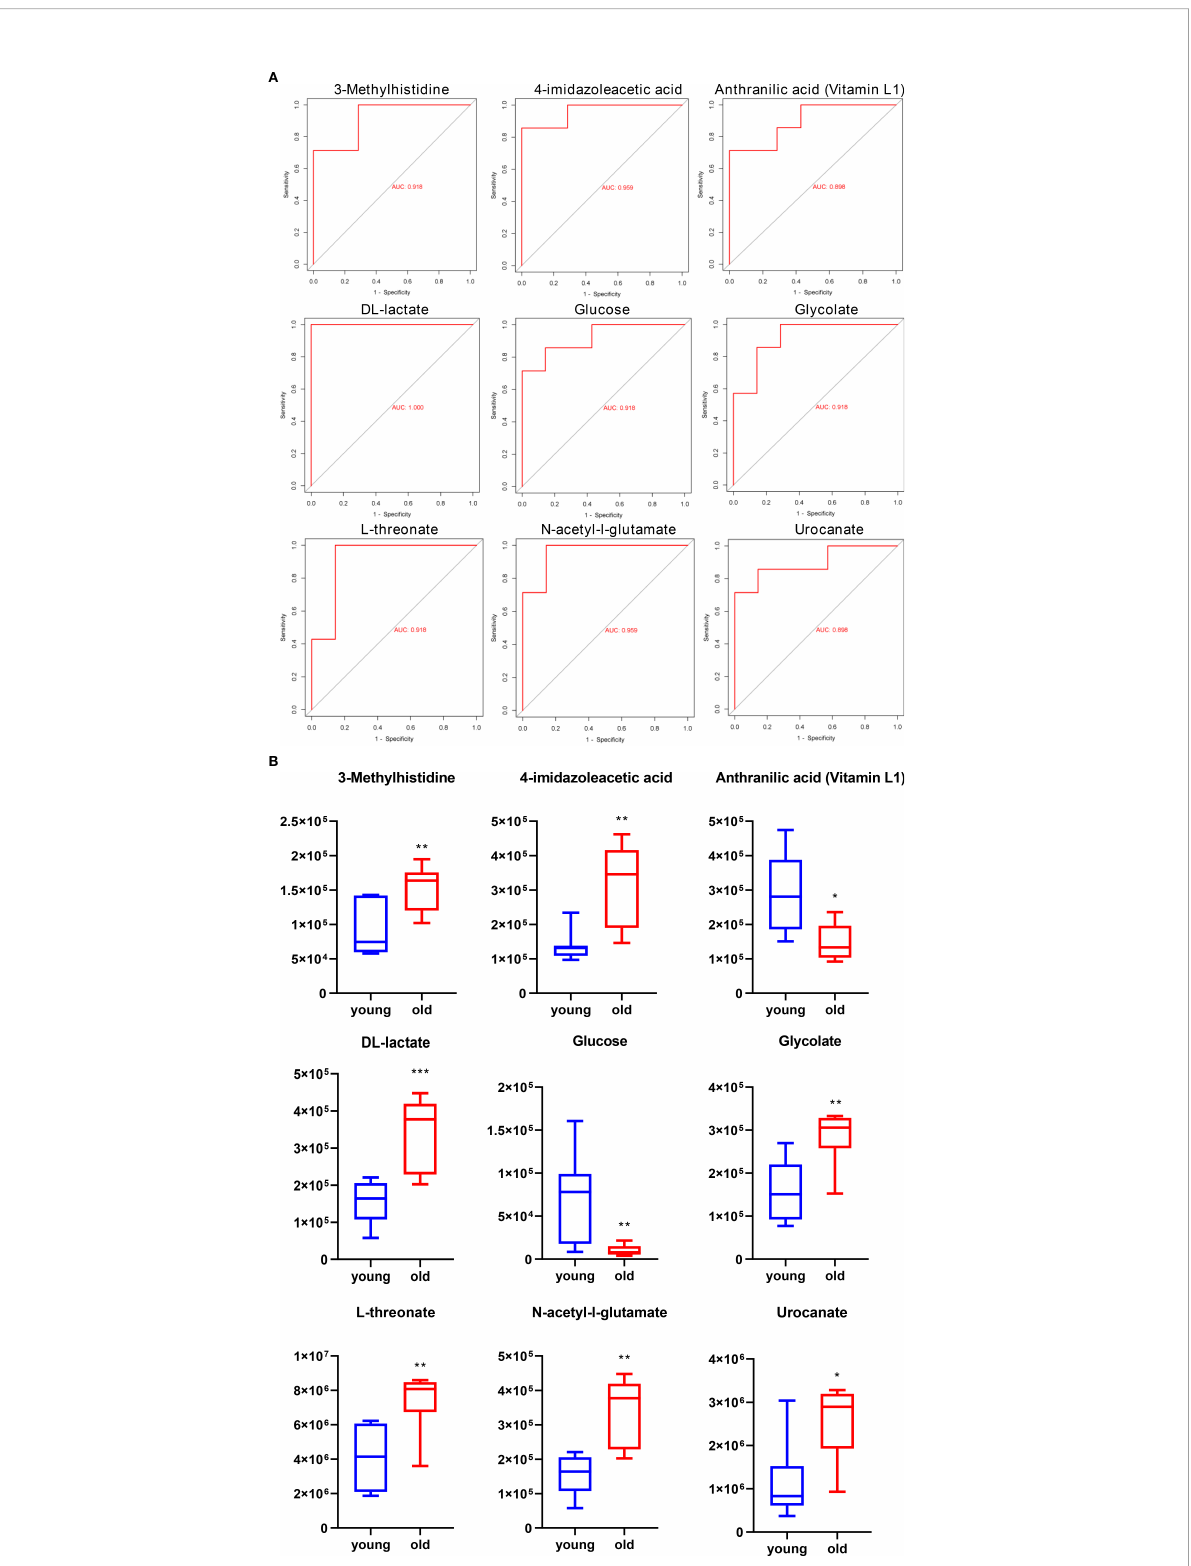
FIGURE 6 ROC curve and normalized abundance of the nine representative biomarkers in the urine. (A) ROC curve for comparing the performance of the different biomarkers. (B) Box plots for the nine potential biomarker abundances in the urine; n = 7, * p < 0.05, ** p < 0.01, and *** p <